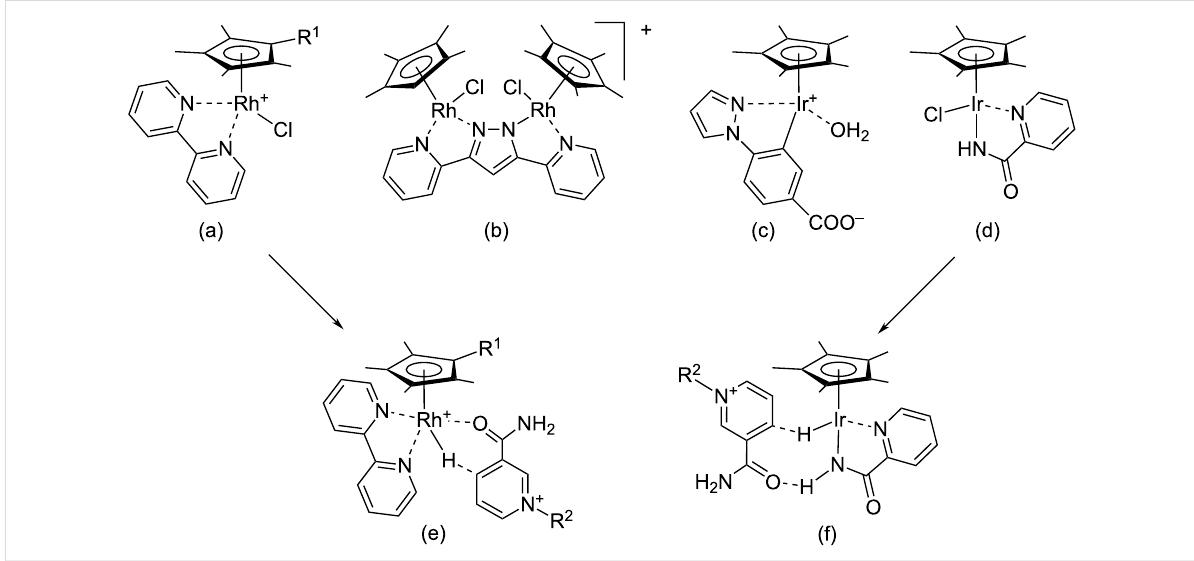
Figure 7: Structural formulas of iridium and rhodium catalysts (a)–(d) for regeneration of NAD(P)H from NAD(P) + and transition states (e) and (f).